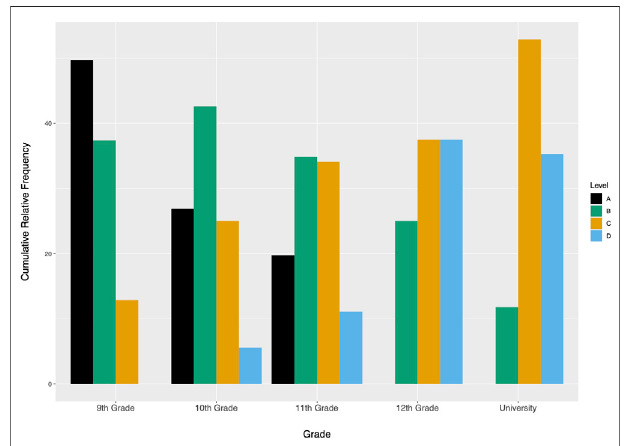
FIGURE 4 | Relative frequency of competency levels among grades ( n (cid:1) 439; Grade 9: n (cid:1) 147; Grade 10: n (cid:1) 108; Grade 11: n (cid:1) 126; Grade 12: n (cid:1) 24; University: n (cid:1) 34).